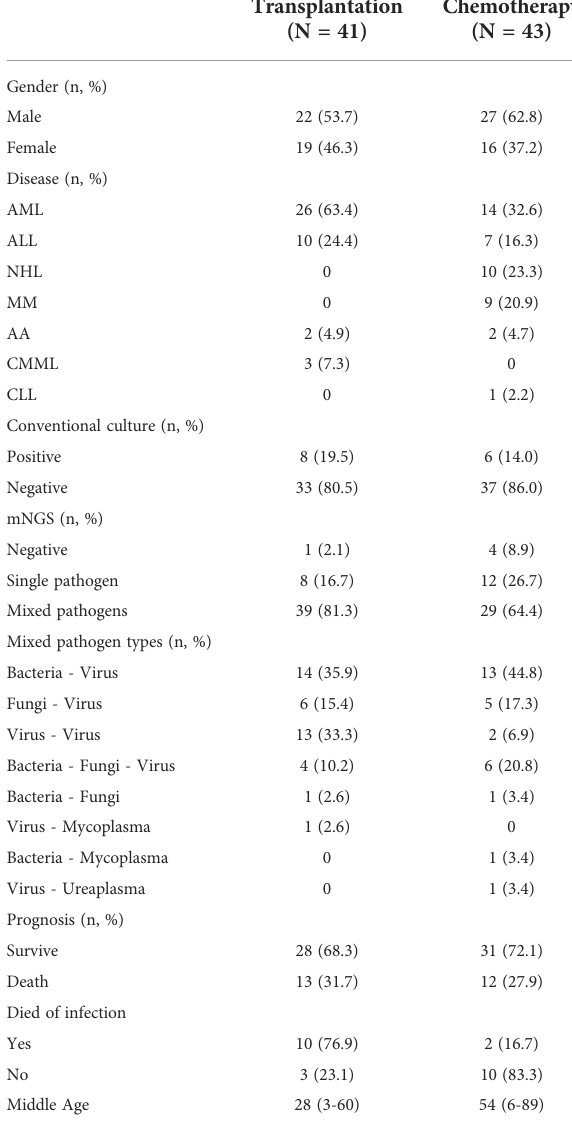
TABLE 1 Characteristics and prognosis of patients